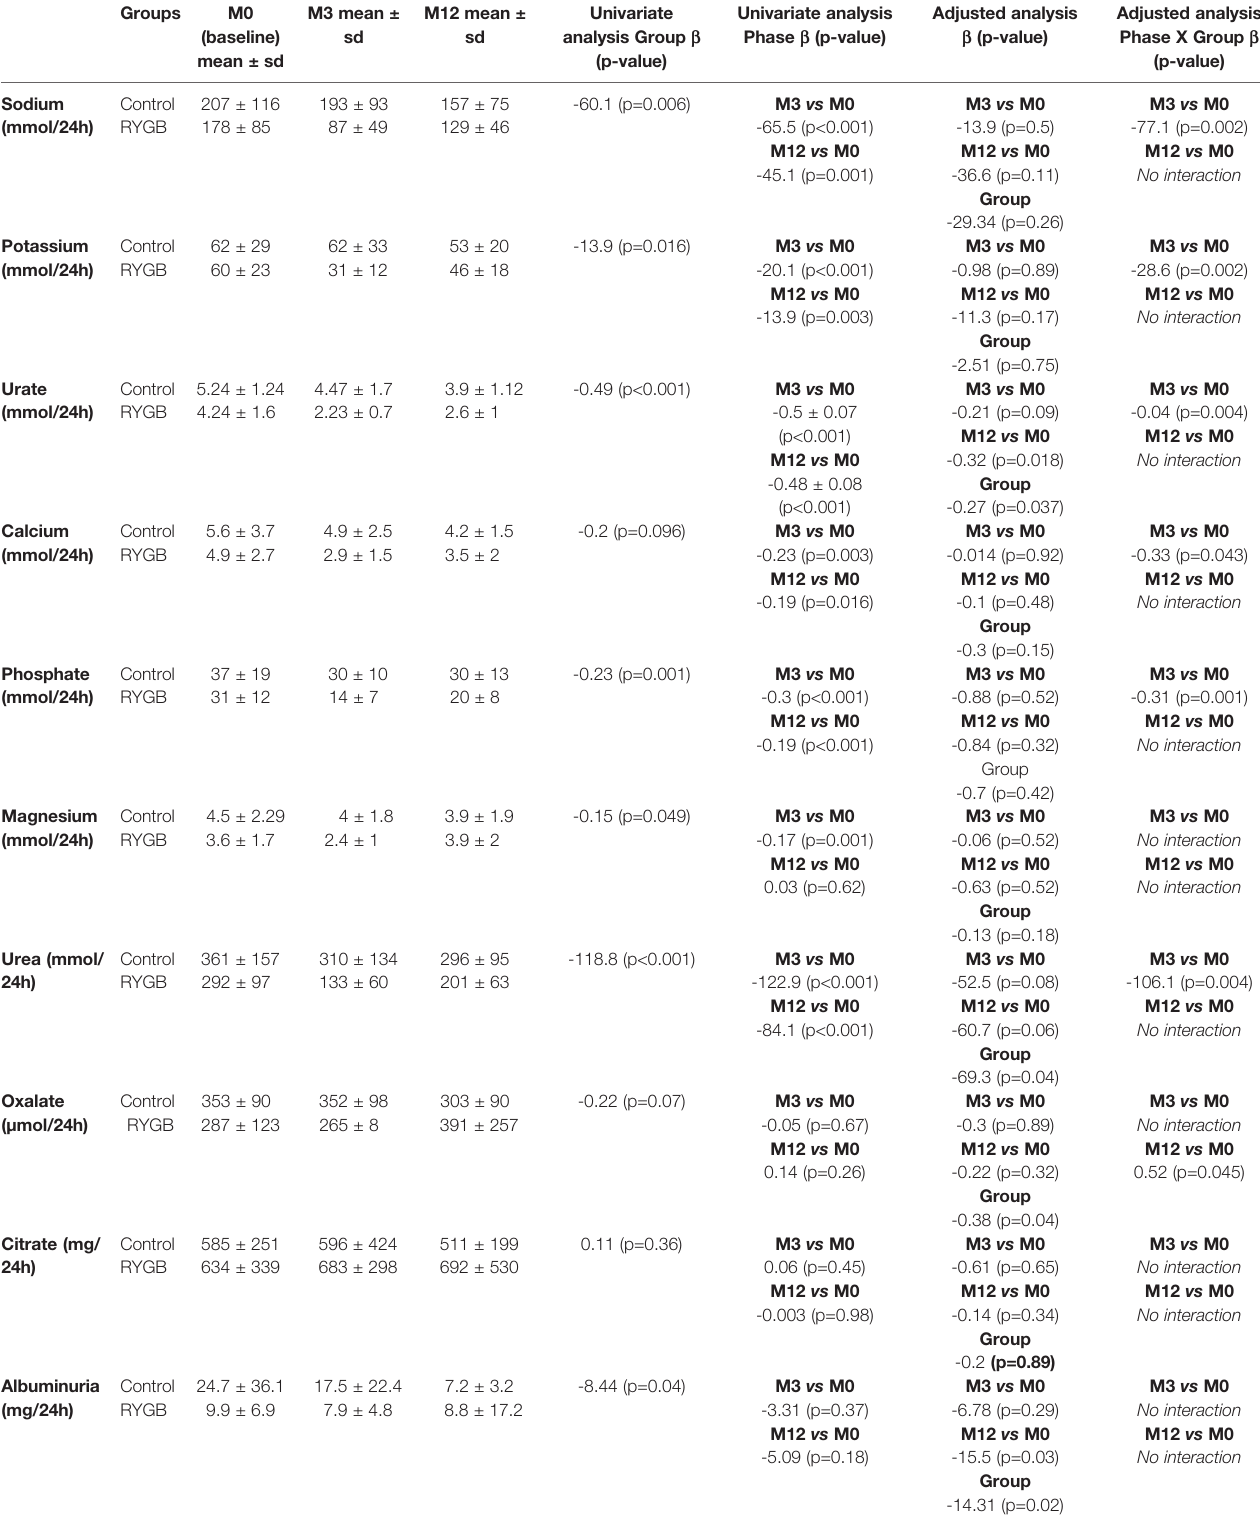
TABLE 3 | Changes in urinary electrolytes excretion, albuminuria, and renal clearances over time.